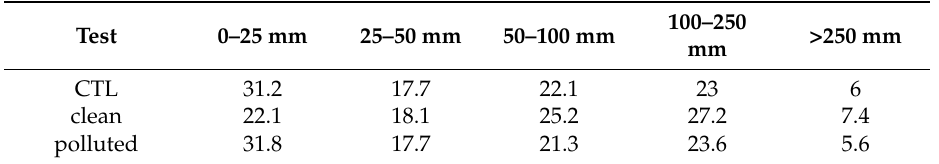
Figure 5. Comparison of the domain-averaged accumulated rainfall amount and maximum accumulated rainfall amount (mm). Table 2. Area percentage of the domain-averaged accumulated rainfall amount in different intervals of the total precipitation area (%).